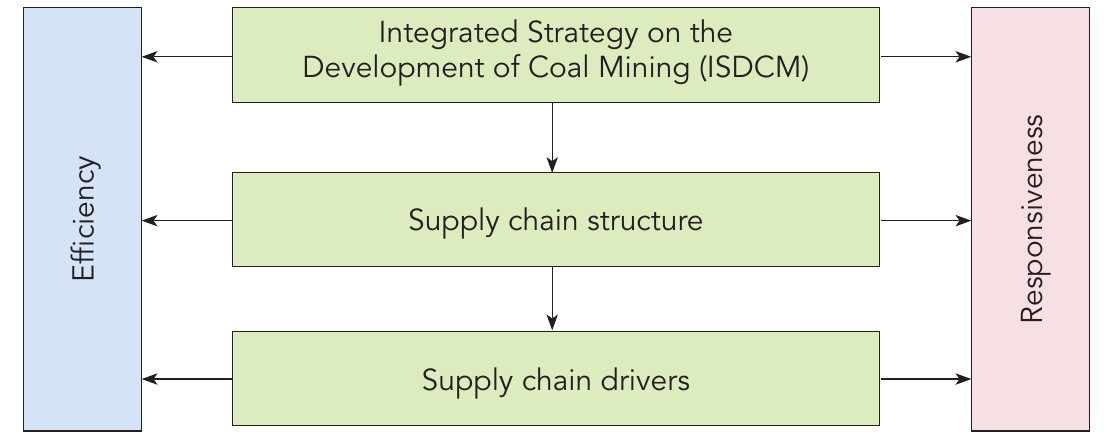
Figure 5: The relation of supply chain drivers towards supply chain strategy Source: Adapted from Nel and Badenhorst-Weiss